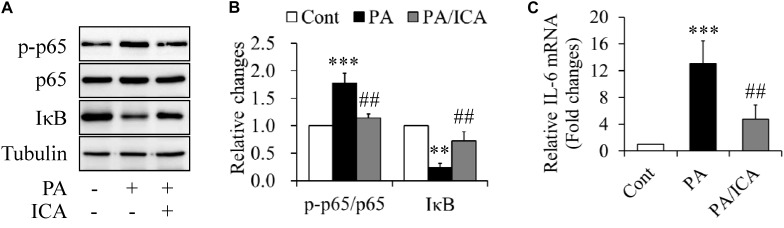
Impacts of icariin on inflammation in PA-treated C2C12 myotubes. (A,B) Effect of icariin (ICA) on NF-κB p65 phosphorylation and IκB protein levels. (C) Effect of ICA on IL-6 mRNA levels. N = 4. ∗∗p < 0.01, ∗∗∗p < 0.001 vs. control (Cont) group; ##p < 0.01 vs. PA group.